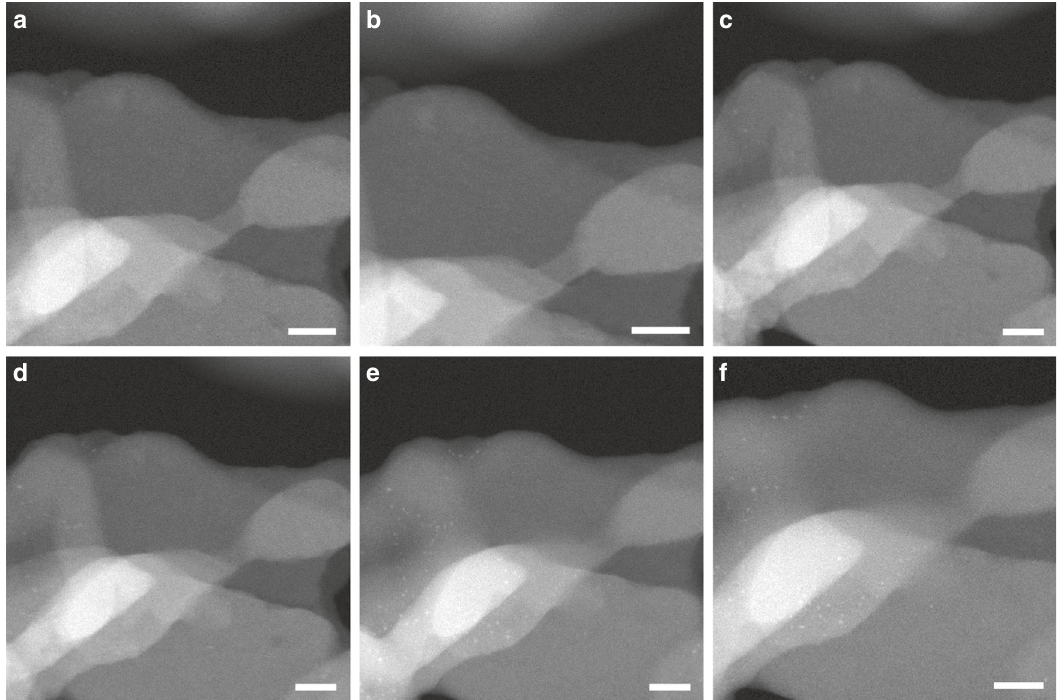
Fig. 6 Stability test of 0.17%Pt@MCM-22-300H 2 under NO + H 2 conditions. During the in situ TEM experiments, the sample was treated in mixture of H 2 (0.1 torr) and NO (0.1 torr) for 15 min at different reaction temperature, respectively. The above images were recorded in the presence of NO+H 2 gases at